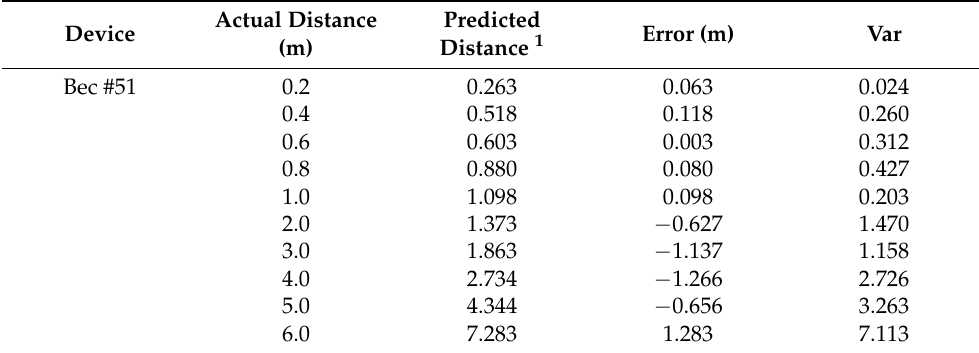
Table 8. Distance prediction and error.